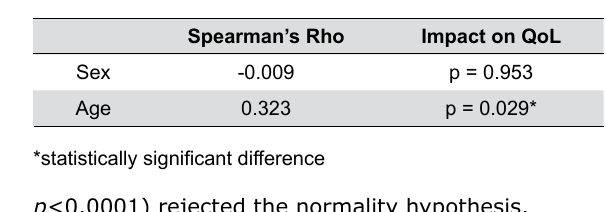
Table 4- Correlation between sex/age and the impact on QoL (Spearman’s Rho